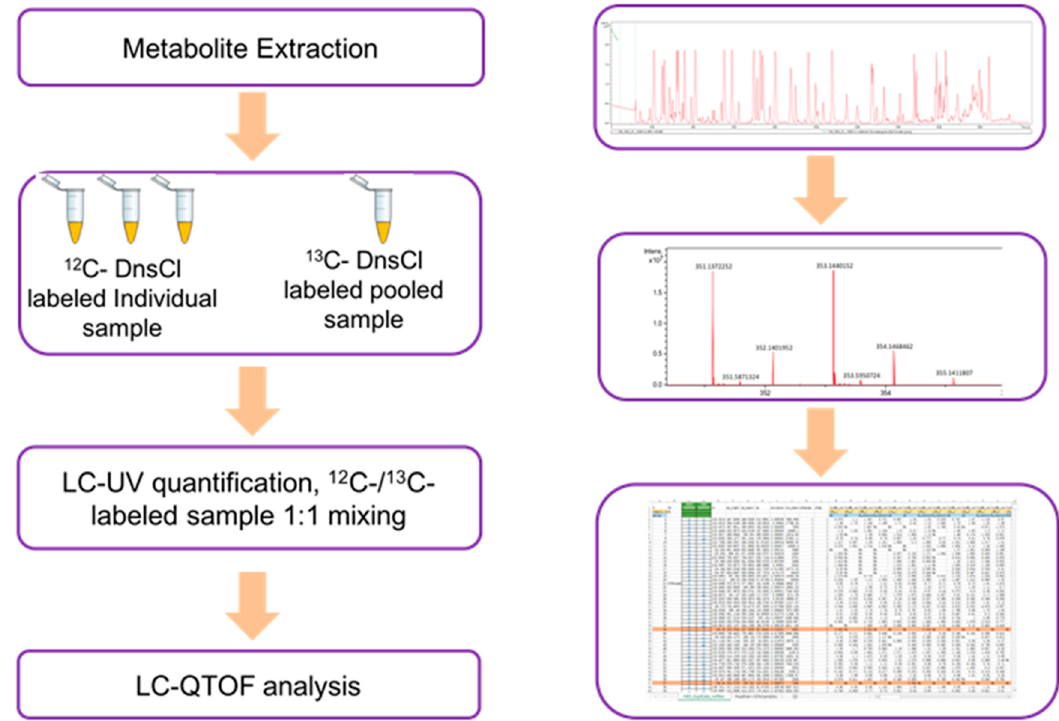
Figure 5. Flowchart of the metabolomics workflow. LC, liquid chromatography; QTOF, quadrupole